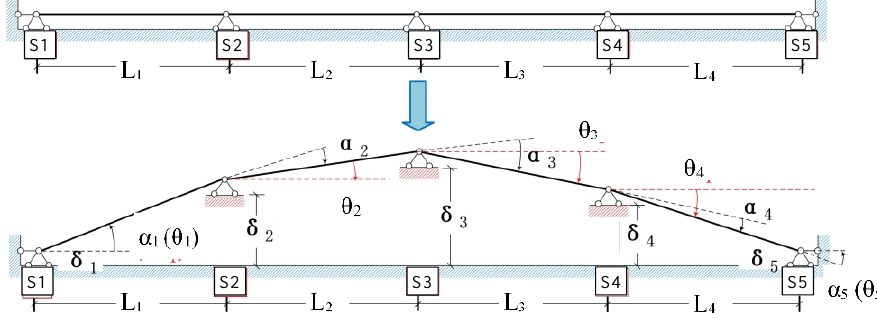
Figure 4. Displacement estimation based on measured rotation angles.